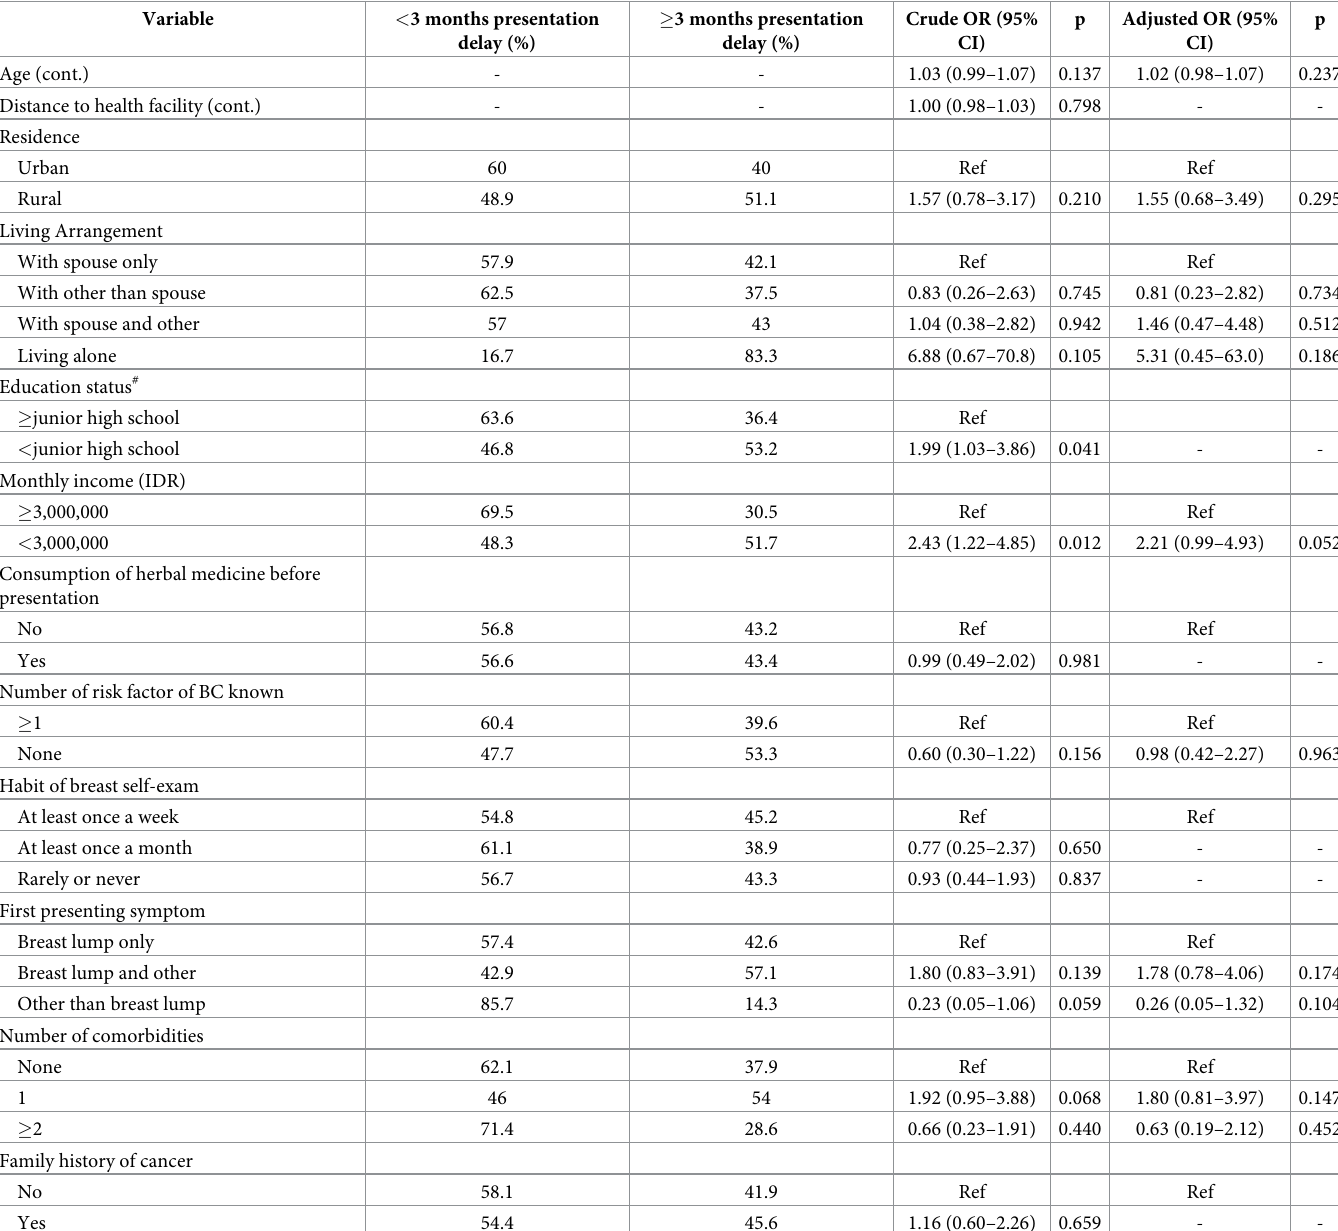
Table 3. Sociodemographic and clinical factors associated with � 3 months presentation delay in breast cancer patients.